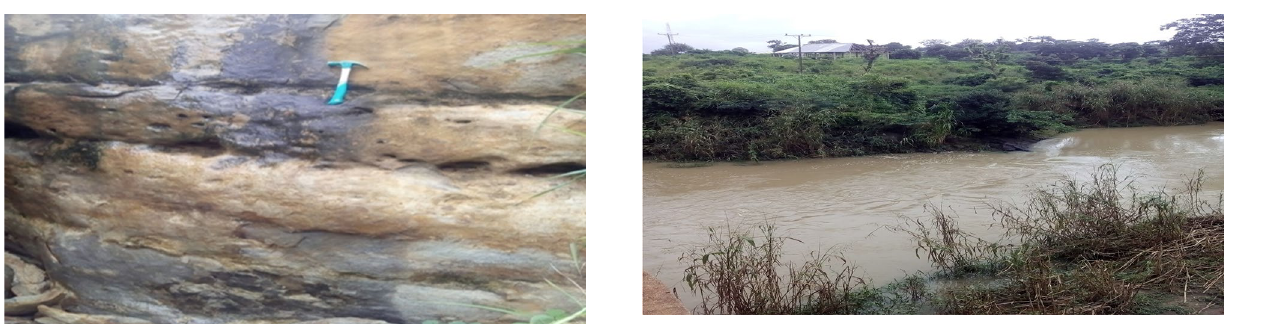
Fig. 12 Calcareous sandstone near Ebonyi State University Perma- nent site (1 km south of Odomoke area)